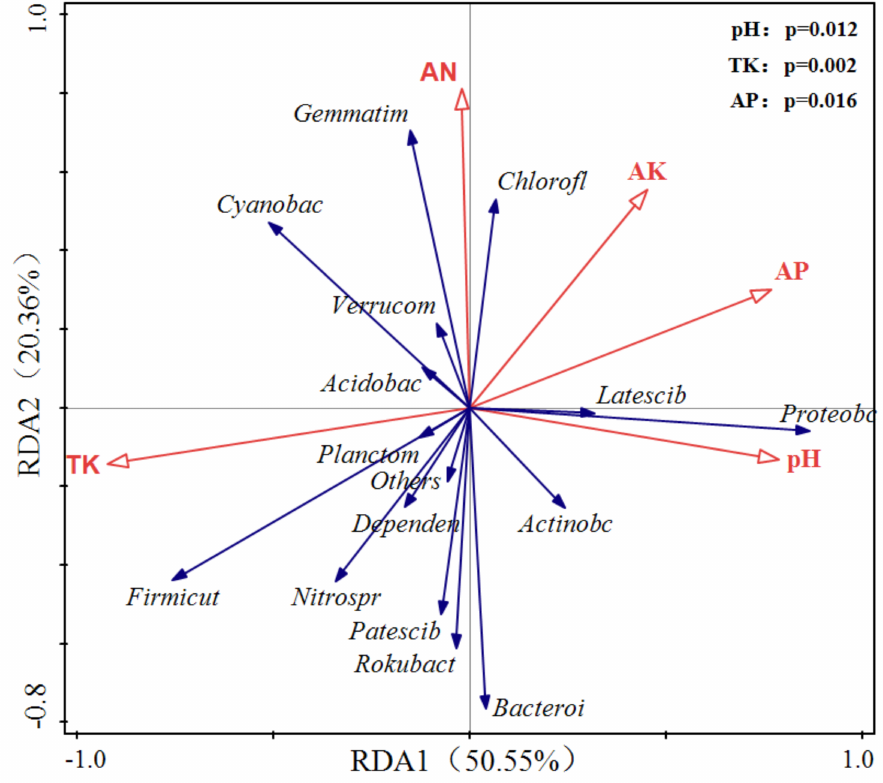
Figure 5. Redundancy analysis (RDA) of the soil bacterial community of ginger field soil and environmental